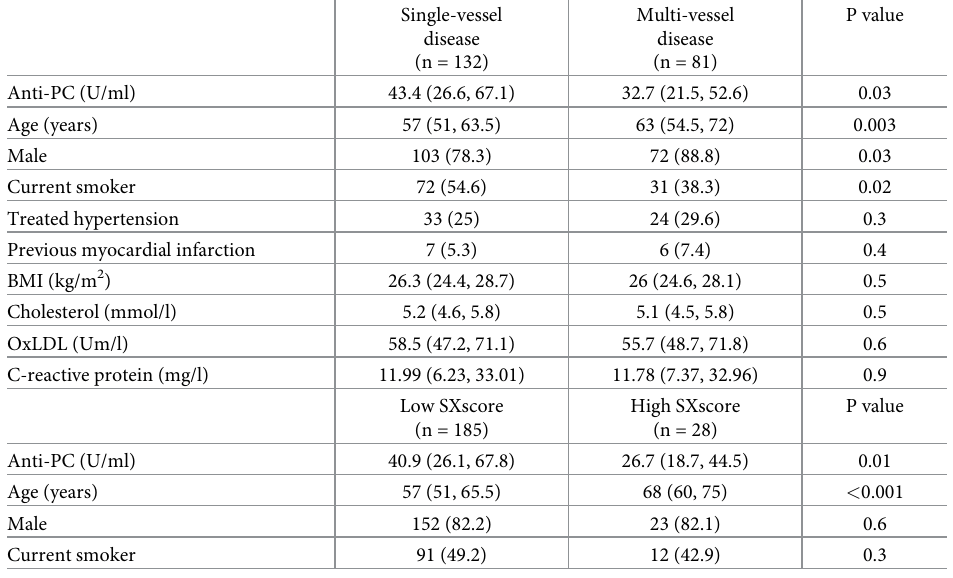
Table 2. Clinical characteristics related to the extent of coronary artery disease diagnosed